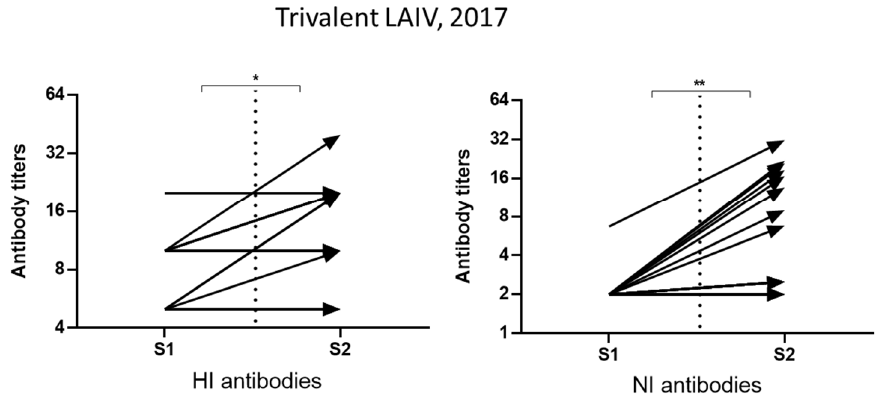
Figure 4. The results of the study of the immunogenicity of the A/H3N2 component of the trivalent LAIV (A/Hong Kong/4801/2014(H3N2)) during the 2017–2018 epidemic season, n = 18. A/17/Victo-